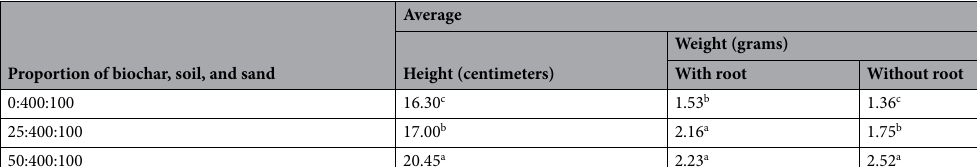
Average Height (centimeters)